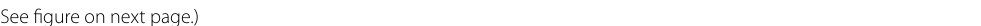
Fig. 1 Rheology of suspensions (packing fraction φ ). a Flow curves and their fits to Eq. (1). Fitting parameters are as follows ; φ = 0 : τ y = 0 (Pa), n = 0.998 , K = 0.10 ( Pa s n ) , φ = 0.1 : τ y = 0.07 (Pa), n = 0.96, K = 0.14 ( Pa s n ) , φ = 0.3 : τ y = 1.2 (Pa), n = 0.91, K = 0.50 ( Pa s n ) , φ = 0.4 : τ y = 4.7 (Pa), n = 0.87, K = 2.0 ( Pa s n ) , and φ = 0.5 : τ y = 27 (Pa), n = 0.75, K = 19.2 ( Pa s n ) . b The φ dependence of relative viscosity η r = η/η l . A red curve indicates η r calculated from Eq. (2) with φ c = 0.60 (indicated by a blue broken line) . c Stress sweeps of storage ( G ′ : large markers) and loss ( G ′′ : small markers) moduli measured under small to large amplitude oscillatory shear at f = 1 Hz. Arrows indicate the linear and non-linear regions of the φ = 0.4 suspension. G ′ ≃ 0 of φ = 0,0.1 suspensions are not plotted. × indicates the G ′ , G ′′ crossover which defines the yield stress τ y (corresponding to a strain γ ∼ 4 × 10 − 3 ). d Frequency sweeps of G ′ (large markers) and G ′′ (small markers), measured under a small amplitude ( γ = 10 − 4 ) oscillatory shear. The thick (thin) broken line indicates the instrumental inertia effect ( G inertia ) of the spindle used to measure the φ = 0 ( φ ≥ 0.1 ) suspension (Additional file 7: Eq. (3)). e Creep curves of φ = 0.4 suspension sheared under the τ indicated in the legend. τ was applied during 0 ≤ t ≤ 5 s and released at t = 5 s (response time < 0.01 s). The γ is normalized by the respective maximum values γ max at t ≃ 5 s, which increases from γ max = 1.4 × 10 − 3 ( τ = 0.2 Pa) to γ max = 6.17 ( τ = 5 Pa). f φ dependence of the yield stress τ y (with errors) obtained from the flow curves ( a ) and stress sweeps ( c ). The bubble buoyancy pressures p (Eq. (5)) are plotted